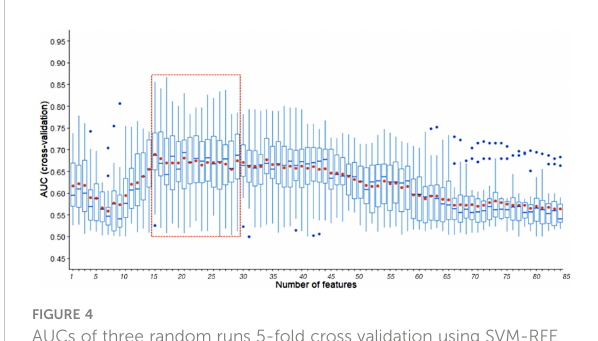
FIGURE 4 AUCs of three random runs 5-fold cross validation using SVM-RFE with a sigmoid kernel. The line in box represents the median, and the red dot represents the average. The part in the red dotted box is the peak region of median and average